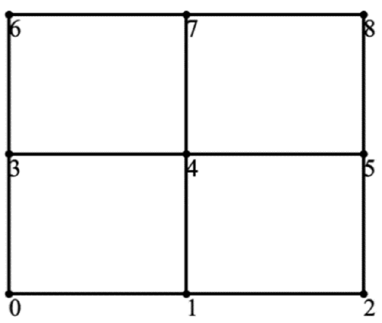
Figure 7. Most efficient graph for 3 × 3 lattice converter from node 0 to node 8.